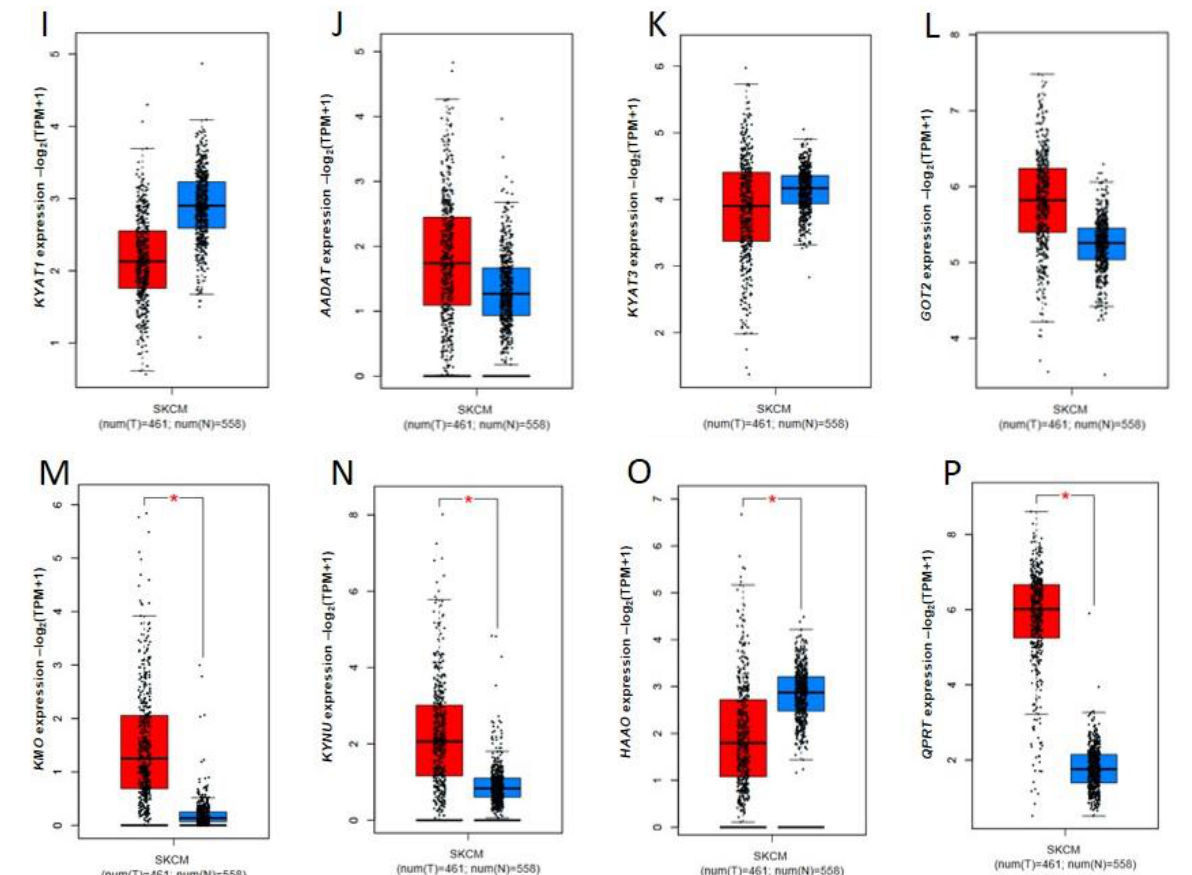
Figure 4. Expression pattern of genes coding proteins involved in the PPAR pathway (( A ) PPARA , ( B ) PPARD , ( C ) PPARG , ( D ) PPARGC1A ) and enzymes of the kynurenine pathway (( E ) IDO1 , ( F ) IDO2 , ( G ) TDO2 , ( H ) AFMID , ( I ) KYAT1 , ( J ) AADAT , ( K ) KYAT3 , ( L ) GOT2 , ( M ) KMO , ( N ) KYNU , ( O ) HAAO , ( P ) QPRT ) in human skin cutaneous melanoma (SKCM) (red; N = 461) in comparison to normal control tissue (skin) (blue; N = 558). Gene expression data from the TCGA and GTEx datasets were retrieved and analyzed by GEPIA2 [79]. Differences in gene expression levels were statistically assessed using ANOVA. * p < 0.01 and fold-change threshold (|Log2FC| cutoff) of 1. TPM, transcripts per million.